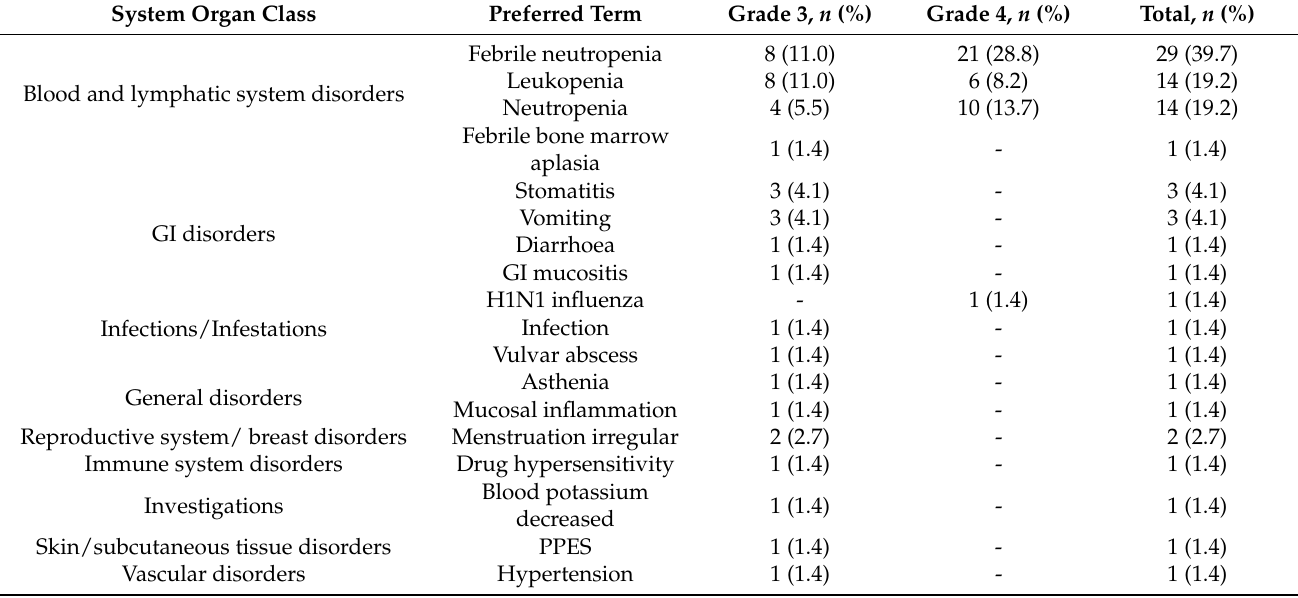
Table 4. Summary of grade ≥ 3 adverse events following